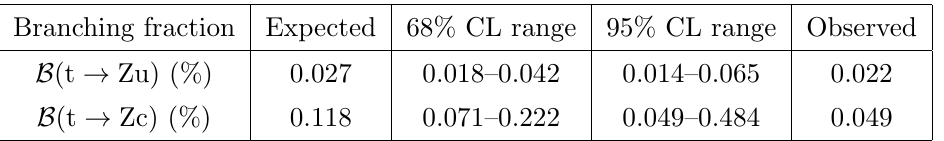
Table 6 . Expected and observed 95% exclusion limits on the branching fraction of the tZ-FCNC